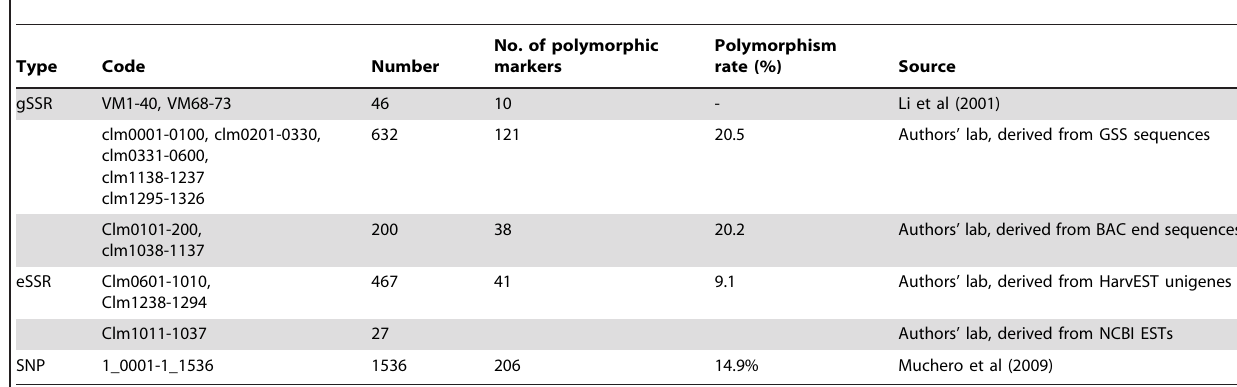
Table 1. Summary of DNA markers